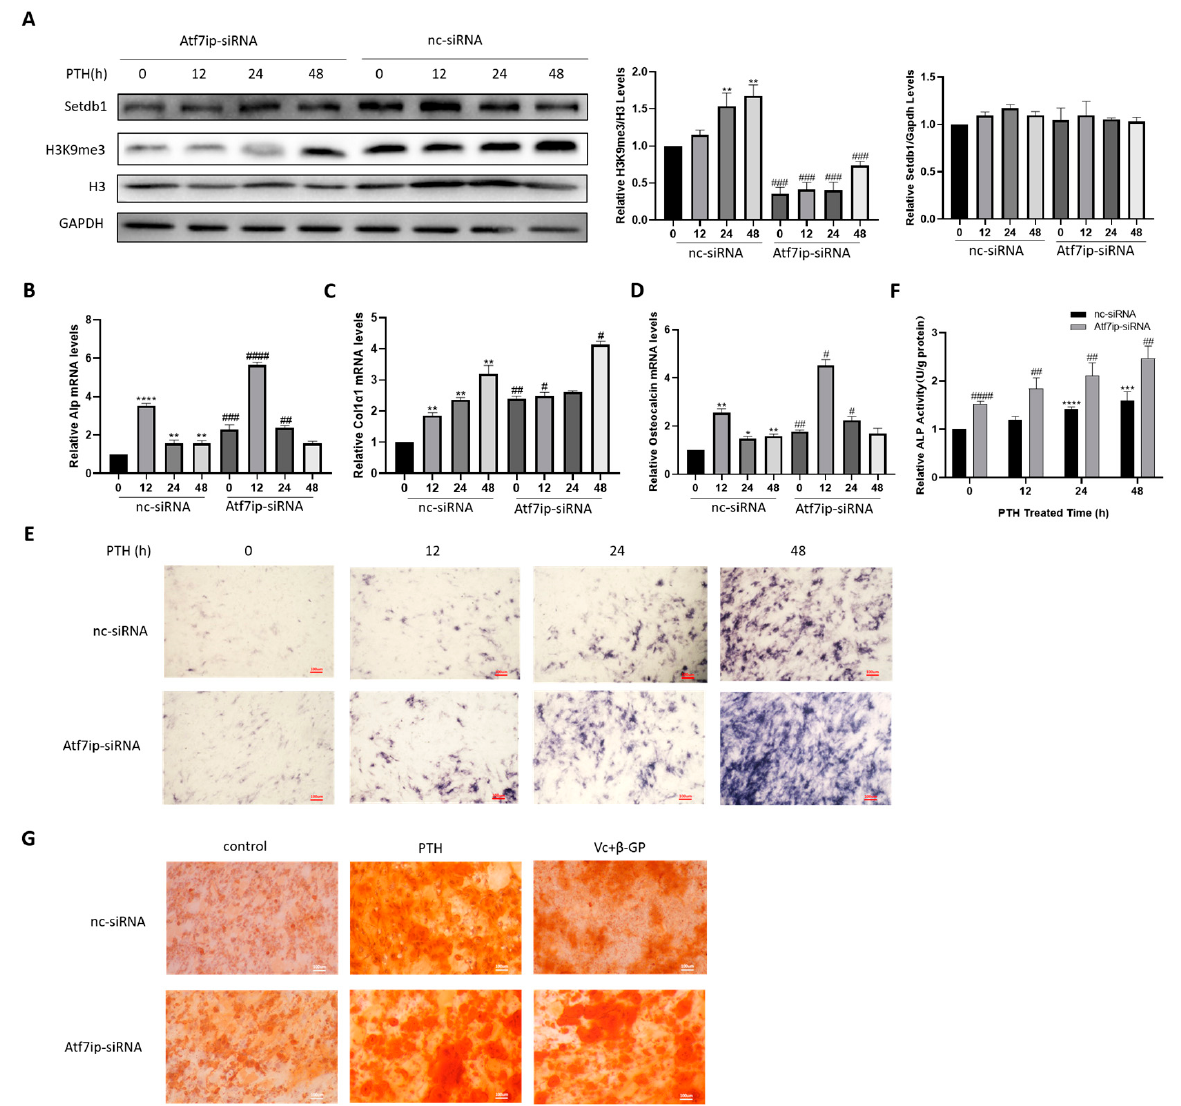
Figure 2. Silencing of Atf7ip expression promotes MC3T3-E1 osteogenesis. MC3T3-E1 cells were firstly transfected with nc-siRNA or verified Atf7ip-siRNA and cultured in 500 ng/mL PTH for the indicated time. ( A ) Western blot with specific antibodies for Setdb1, H3K9me3, and H3. Gapdh was used as the loading control, n = 3. ( B – D ) mRNA levels of Alp , Col1a1 , and Osteocalcin examined by real-time PCR, n = 3. The results of alkaline phosphatase staining ( E ), the Alp activity assay ( F ), and Alizarin red staining ( G ). Scale bar, 100 µ m. The experiments were repeated at least three times. Data are expressed as mean ± SD. The significance was measured by one-way ANOVA, * p < 0.05, ** p < 0.01, *** p < 0.001, **** p < 0.0001, treatments vs. no treatment; # p < 0.05, ## p < 0.01, ### p < 0.001, #### p < 0.0001, Atf7ip-siRNA vs.